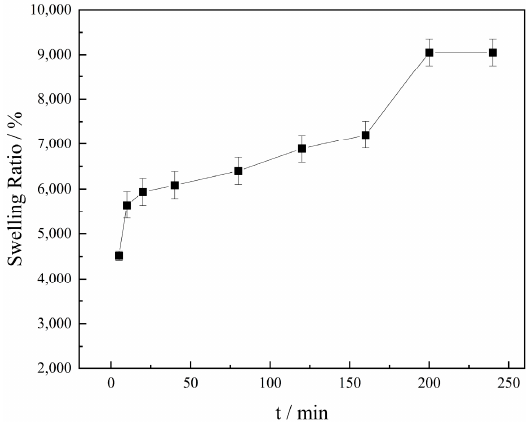
Figure 5. Swelling property of